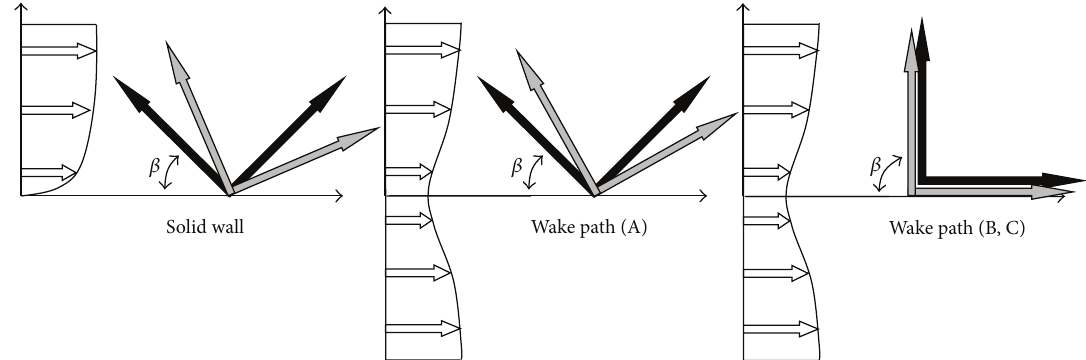
Figure 11: Sketch of the strain tensor eigenvectors (black) and stress tensor eigenvectors (grey) in a turbulent boundary layer (left), and in two positions A and B, as detailed in Figure 10, along a typical